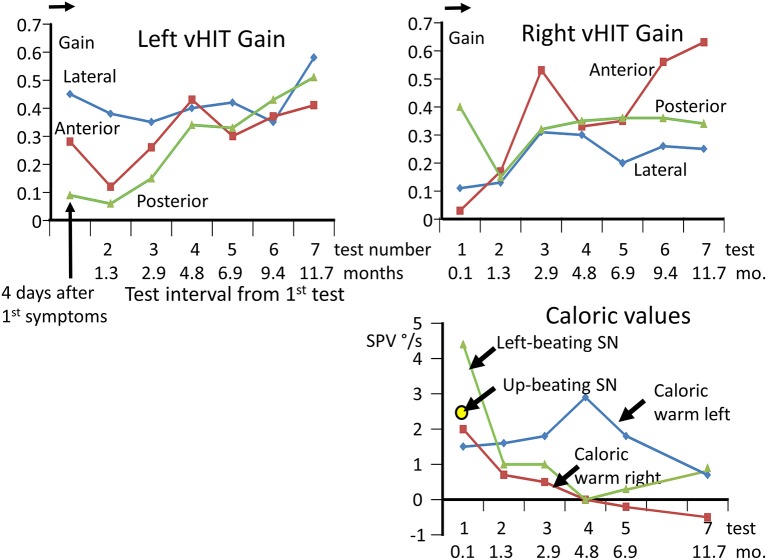
Upper panels: changes in vHIT gains in each canal direction, from 4 days after onset of acute symptoms until 11.7 months later. A total of 7 tests were performed. Note the gradual improvement in the vHIT gains except for the left lateral and right posterior gain. All gains are lower than normal as marked by the arrow on the gain ordinate, indicating the lower 95% limit of healthy controls (23). Lower right panel: caloric measurement values over time and levels of spontaneous nystagmus. The values for the nystagmus slow phase velocity (SPV) elicited during the culmination phase 60–80 s from the start of a 60 s irrigation of 44°C are listed after subtraction of the SPV of the left-beating spontaneous nystagmus recorded over 20 s prior to the irrigation. Because of the small values, the canal paresis was not calculated. For the examination at 4 days only, an up-beating vertical spontaneous nystagmus was also observed.